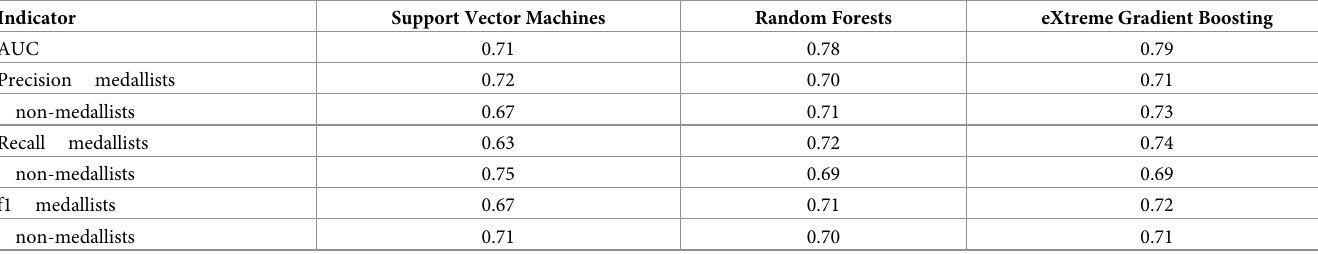
Table 3. Assessed classification accuracy of different